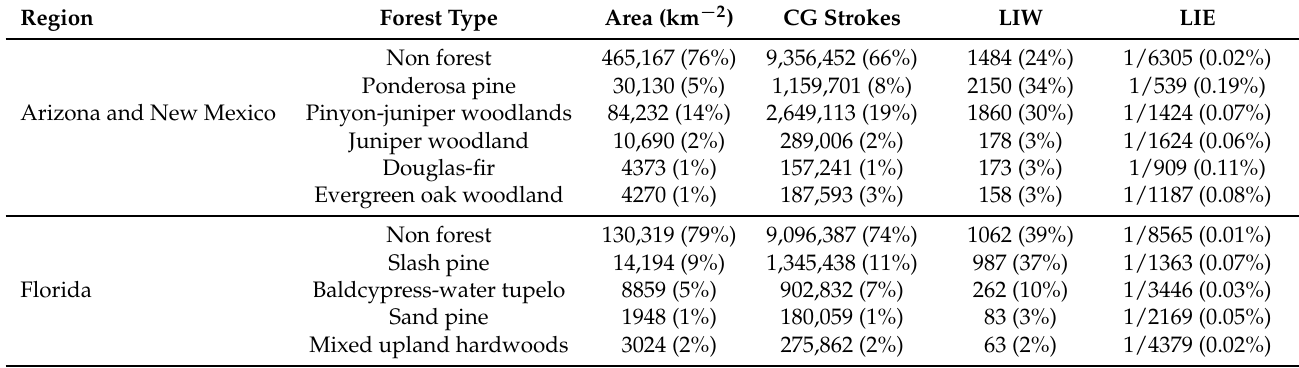
Table 1. LIE in forest types of Arizona and New Mexico as well as Florida. Only forest types